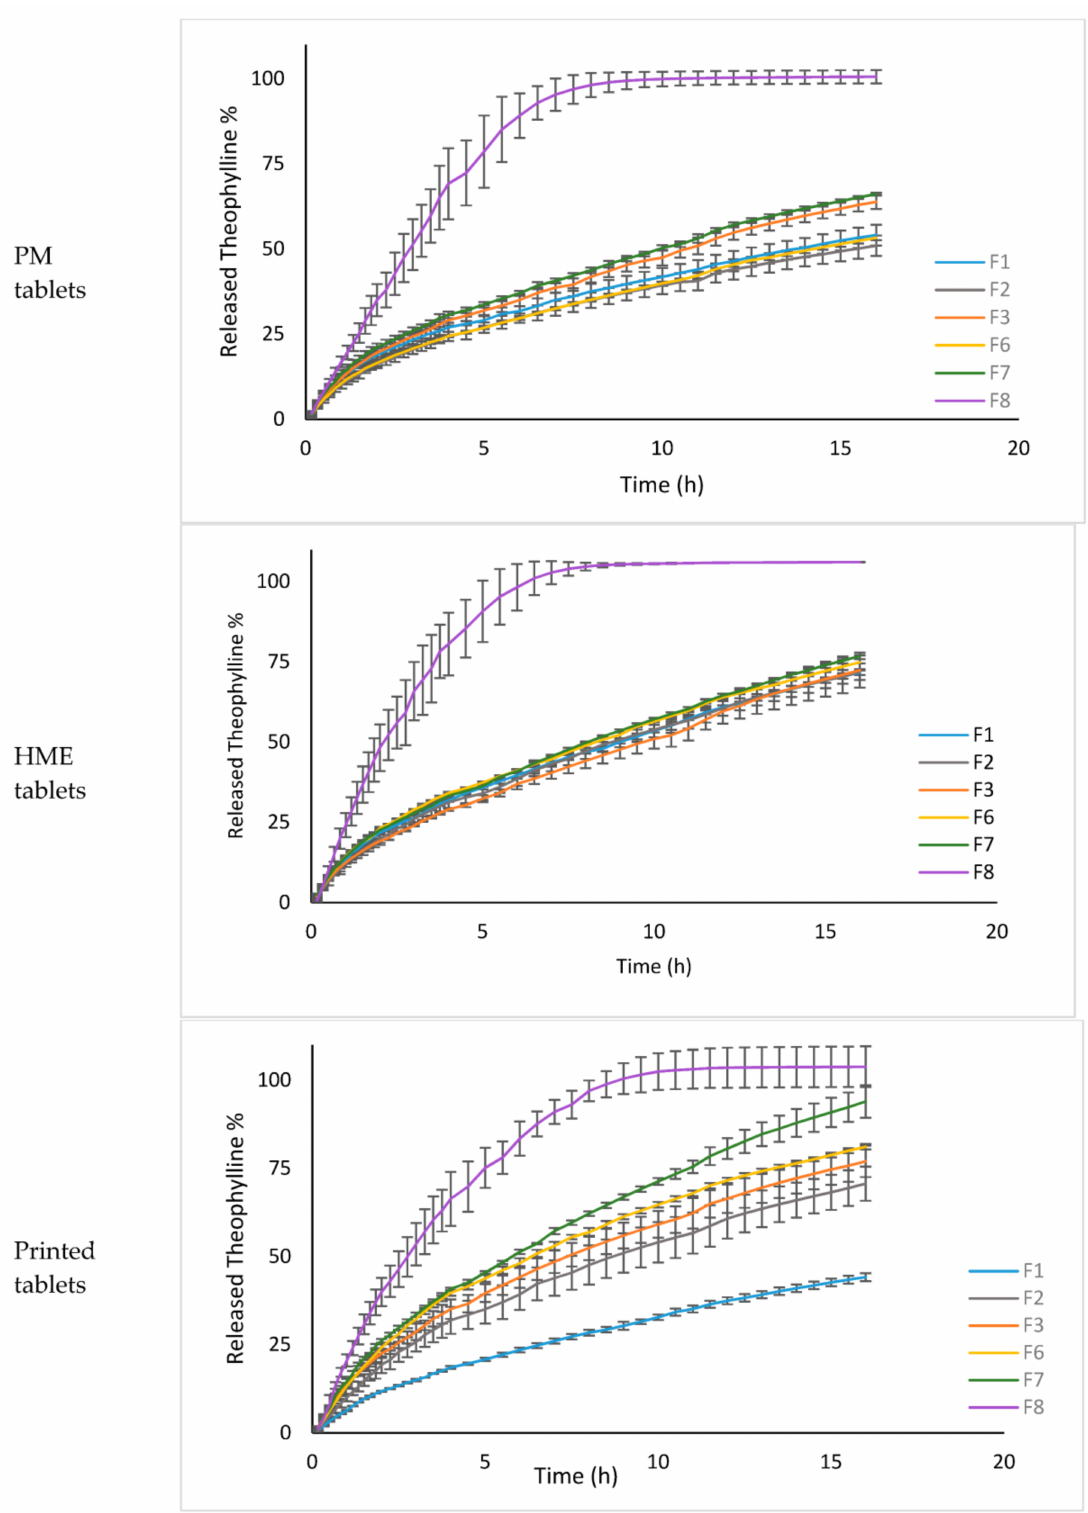
Figure 7. Comparison of the release percentage among the studied formulations in the three prepara- tion